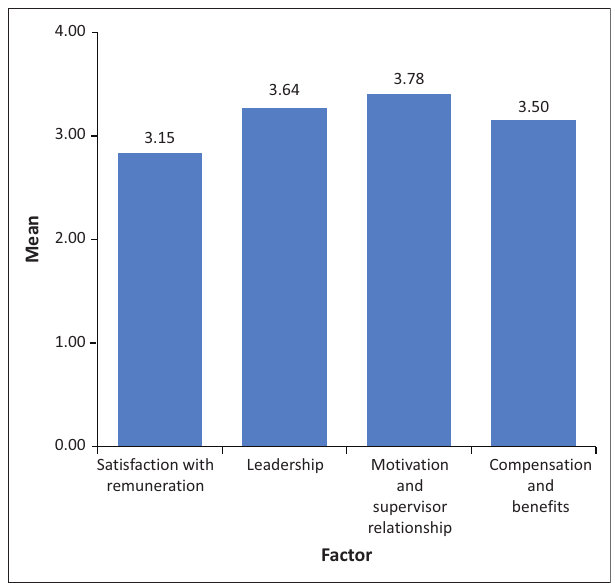
FIGURE 1: Descriptive statistics per